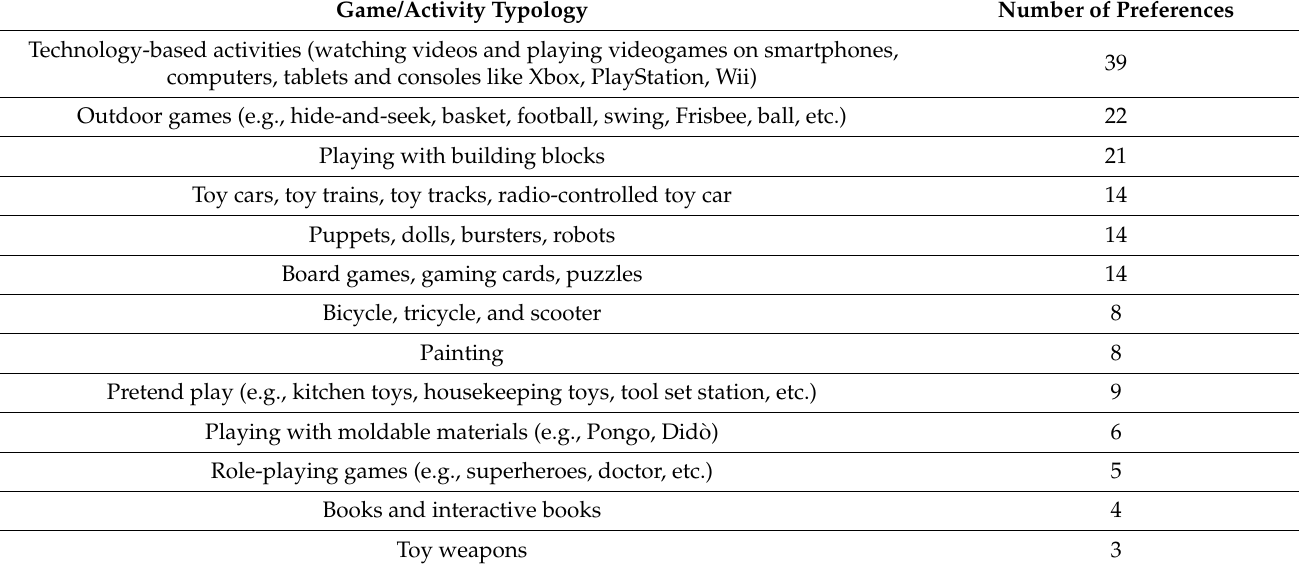
Table 3. Games that mostly engage children with neurological impairments as reported by their parents. Game/Activity